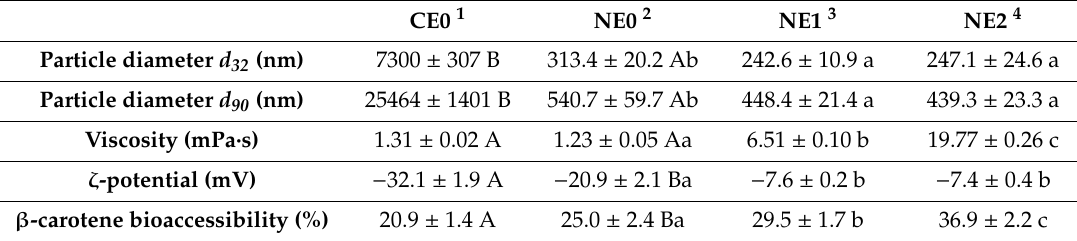
Table 1. Particle size, viscosity, ζ -potential, and β -carotene bioaccessibility of coarse emulsion and nanoemulsions with di ff erent pectin concentrations (0%, 1%, and 2%). Values are expressed as mean ± standard deviation. Di ff erent capital letters indicate significant ( p < 0.05) di ff erences between the coarse emulsion and nanoemulsion without pectin. Di ff erent lower case letters indicate significant di ff erences ( p < 0.05) between nanoemulsions with di ff erent pectin concentrations.